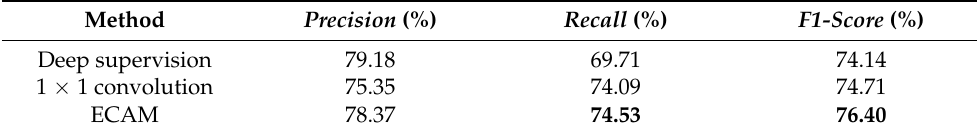
Figure 11. The workflow of different methods in the training and prediction phases. ( a ) the original deep supervision method, which uses multiple prediction maps for joint back-propagation during the training step, but only a single feature map was used for prediction; ( b ) 1 × 1 convolution-based method that improves the training and prediction disparity in the method ( a ); ( c ) ECAM module- based method, which provides fine-grained change maps by weighting the attention of multiple feature maps and performing information aggregation. Table 6. Accuracy results of DSNUNet for different feature fusion methods.